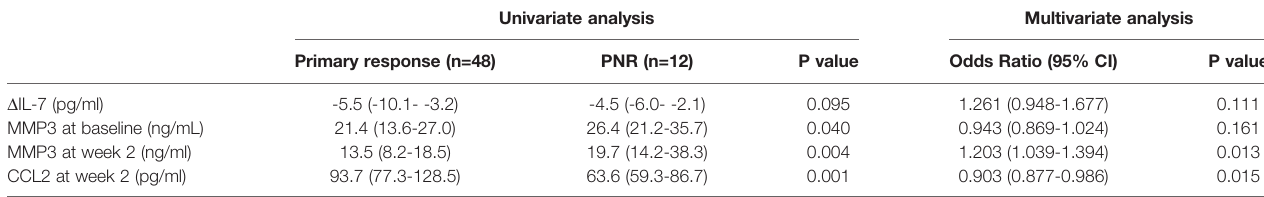
TABLE 2 | Comparison of serum biomarkers detected by ELISA between primary non-responders and responders in cohort 1.